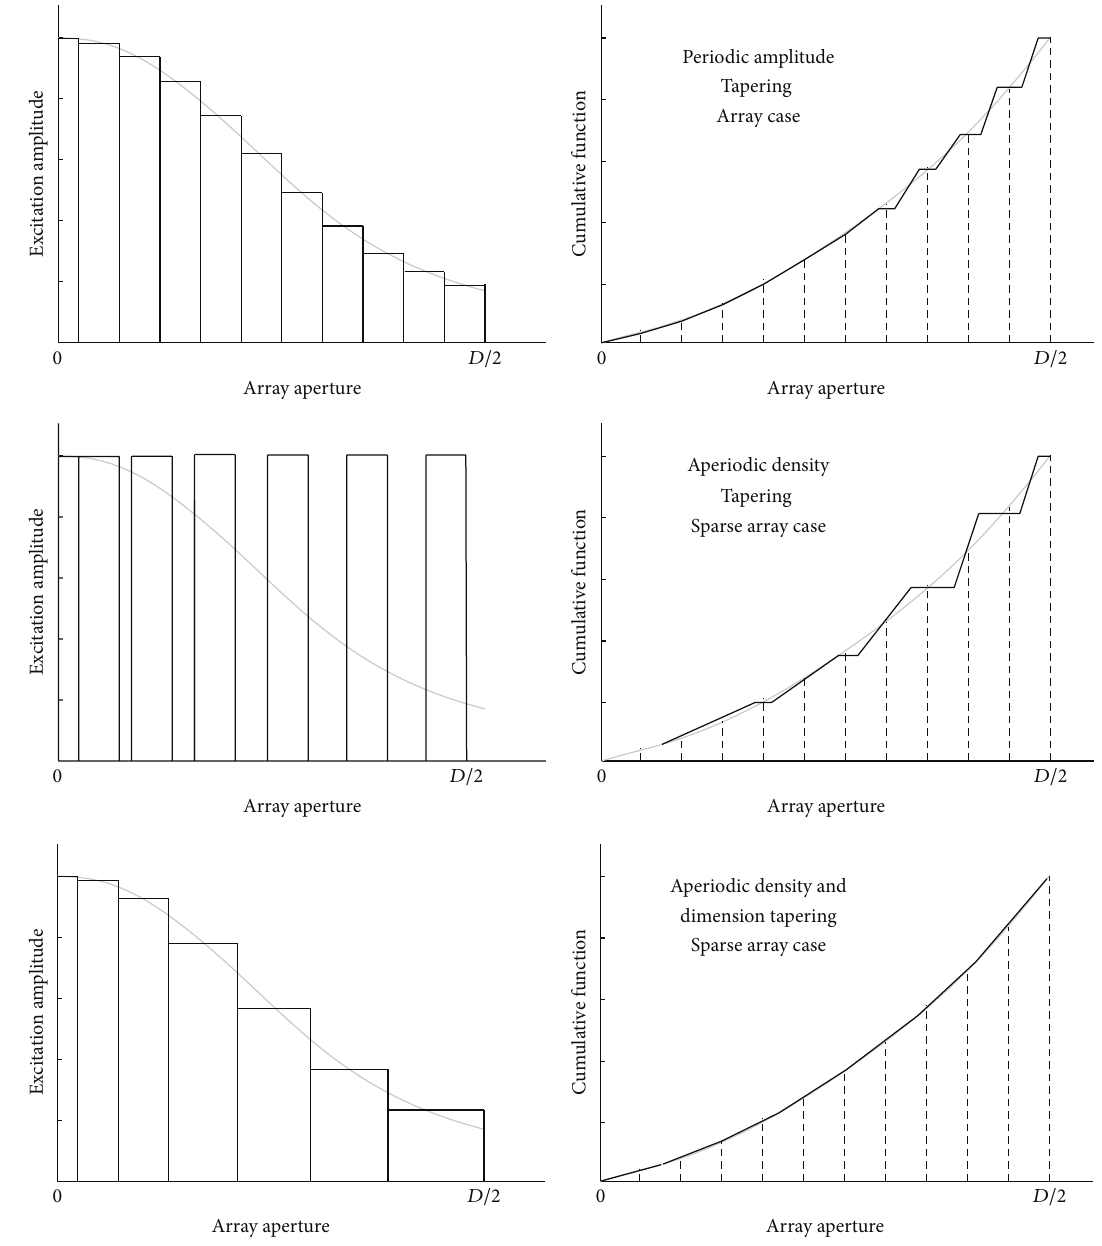
Figure 1: High aperture efficiency sparse array synthesis